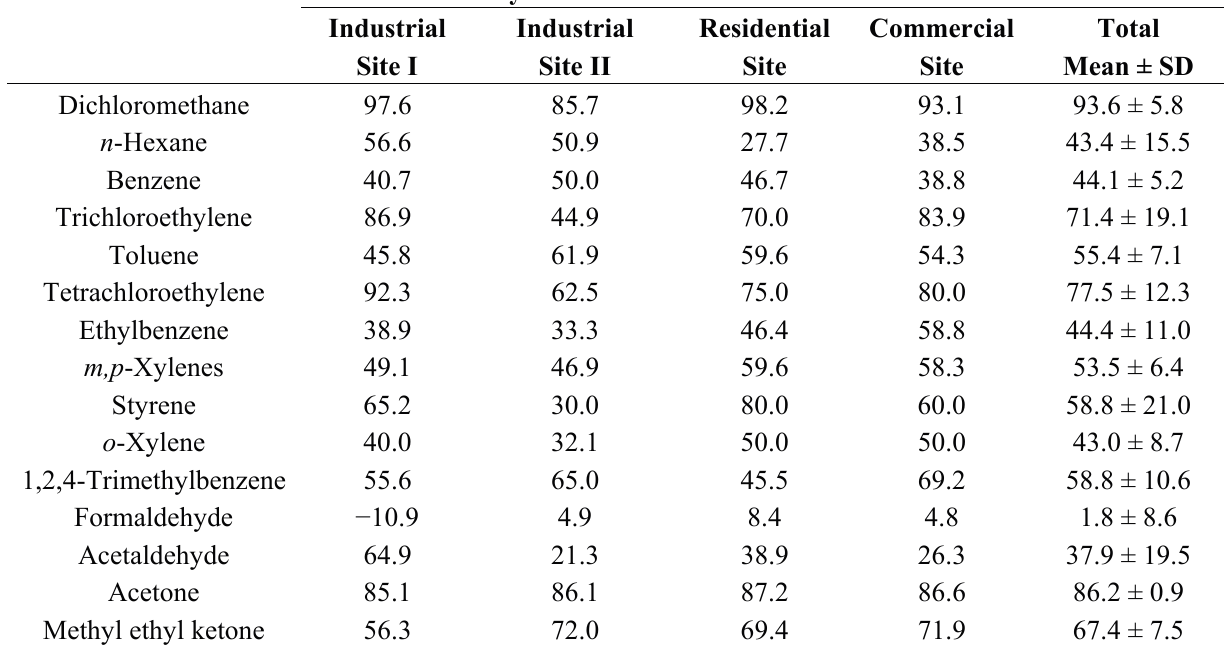
Table 6. Estimation of the reductions of the average concentrations (in ppb) of selected VOCs in the 2010/2011 campaign relative to the 2003/2004 campaign in Gumi